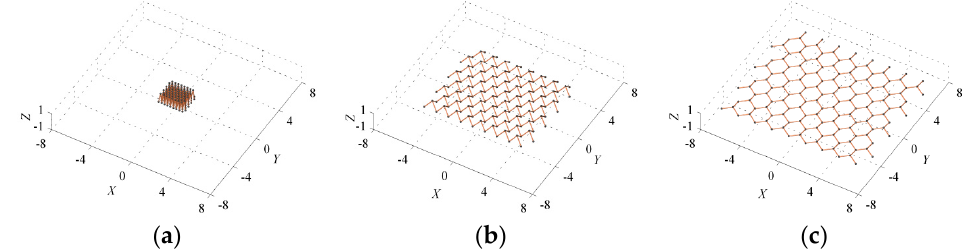
Figure 5. Motion of a deployable structure assembled by 8 × 8 basic units, with n 1 = n 2 = 3: ( a ) Folded configuration; ( b ) partially deployed configuration; ( c ) deployed configuration.